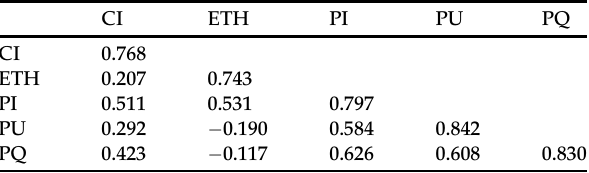
Table 3. Discriminant validity.